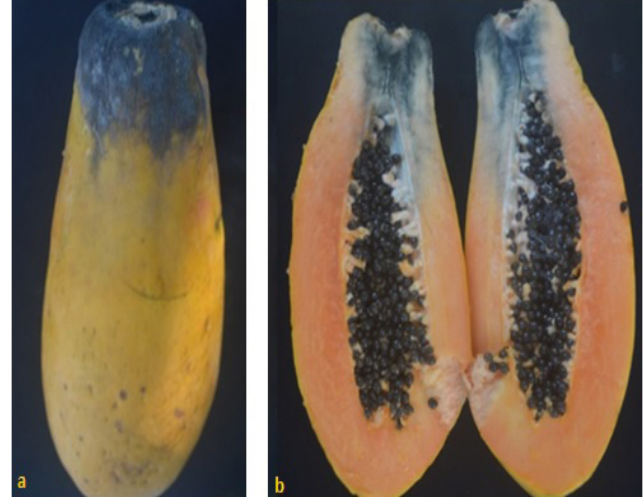
Figure 3: (a) External symptoms of SER on ripe avocado fruit, and (b). A vertically halved avocado showing internal pulp symptoms due to SER.